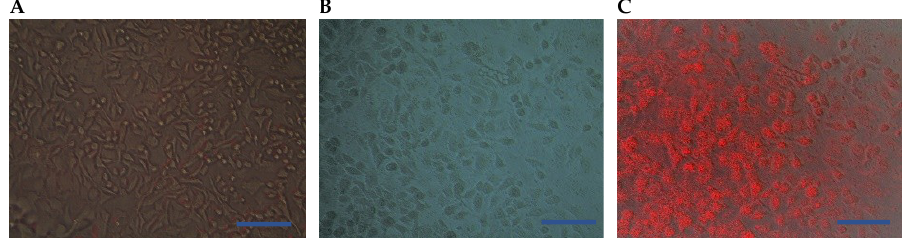
Figure 6. Representative photomicrographs ( A ) Optical tomography (using NIR laser) for Caco2 cells was treated with NIR laser only, ( B ) Cells treated with 2 µg/mL of C-TPP NPs, ( C ) Optical tomography using NIR laser for the treated cells (2 µg of C-TPP NPs), Scale bar 20 µm.